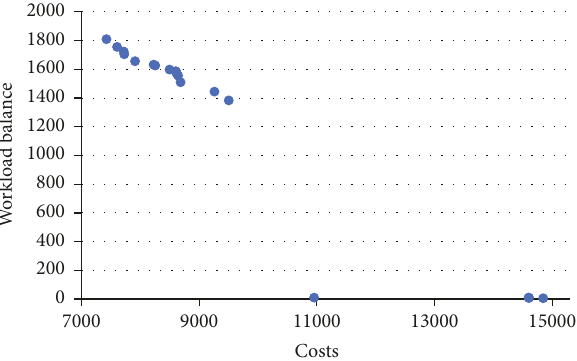
Figure 11: Approximation of the Pareto front of Instance